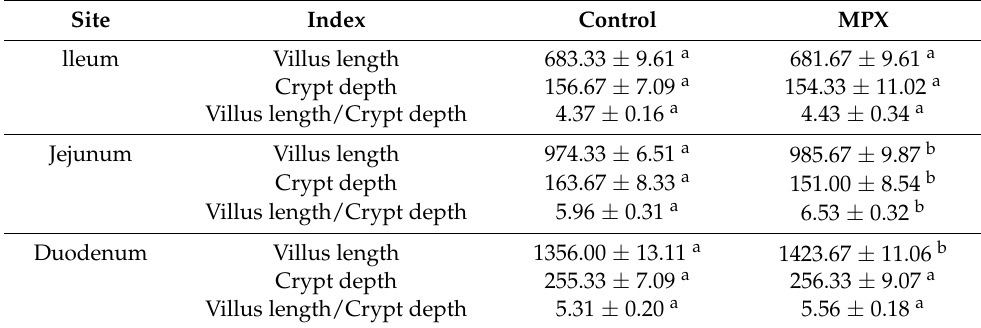
Table 4. Effects of MPX on the intestinal villus index of the ileum, jejunum and duodenum of 28-day-old chickens.